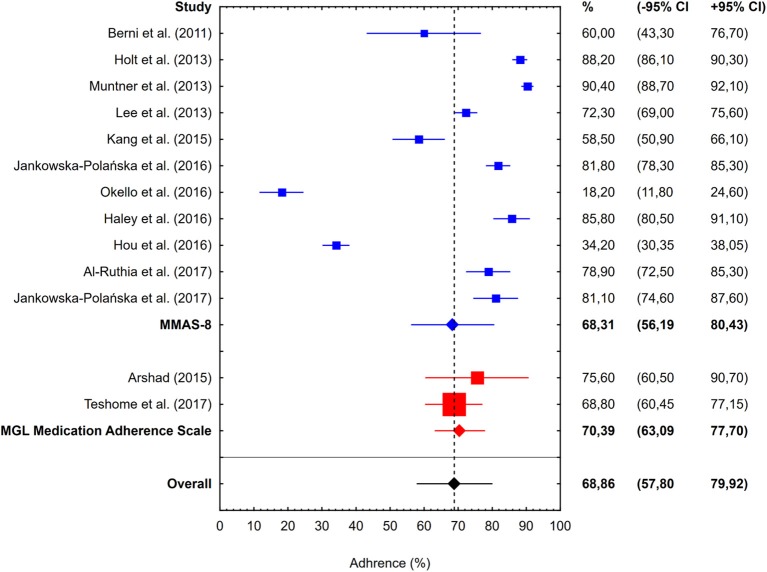
Percentages of hypertensive patients identified as adherent in 13 studies included in the meta-analysis, stratified according to the type of medication adherence scale used: MMAS-8 (11 studies, blue boxes, and whiskers) or MGL Medication Adherence Scale (2 studies, red boxes, and whiskers). Blue and red diamonds represent overall adherence determined in the studies using MMAS-8 and MGL Medication Adherence Scale, respectively. Meaning of other symbols identical as in Figure 2.